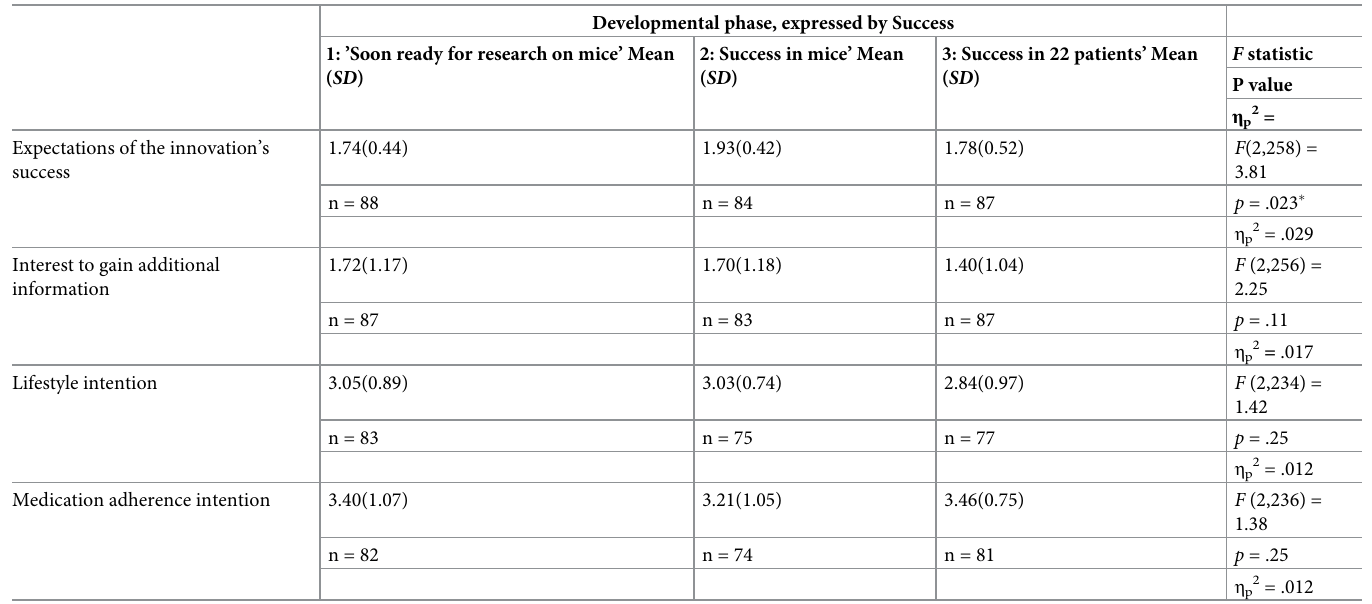
Table 4. Results one-way ANOVA: between group differences as filled in on a 5 point likert scale 0–4; mean/neutral = 2.0 (Developmental phase). Developmental phase, expressed by Success